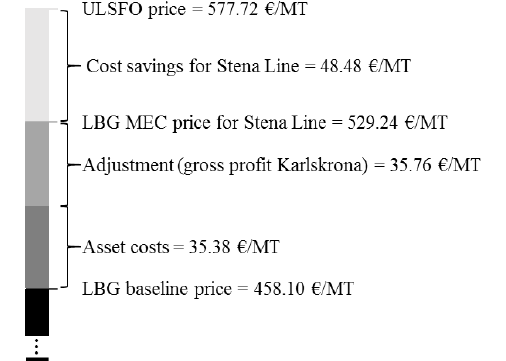
Fig. 1. Gross profits and cost savings by the LBG MEC business